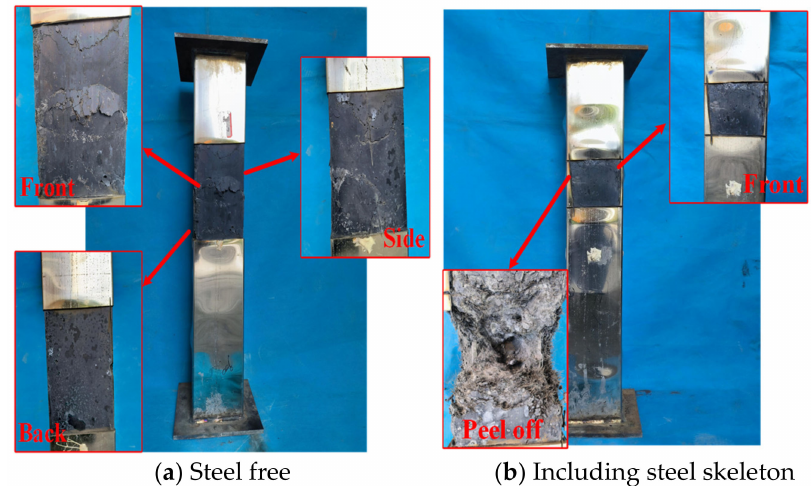
Figure 11. Failure modes of typical specimens.